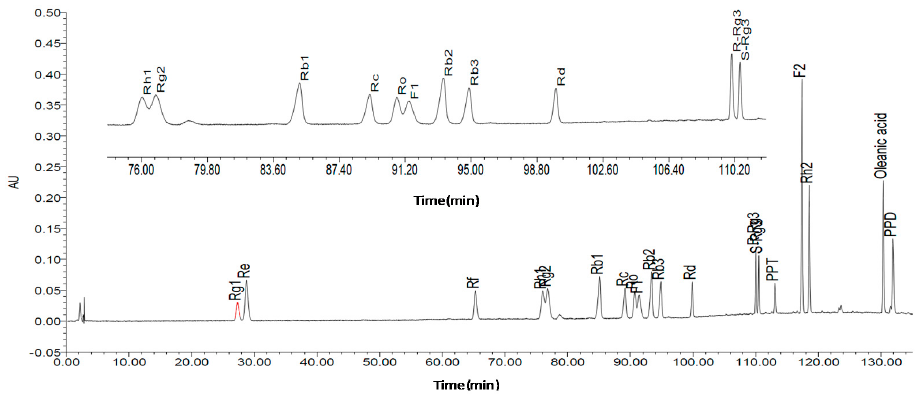
Figure 1. High performance liquid chromatography (HPLC) record of mixture of standards.